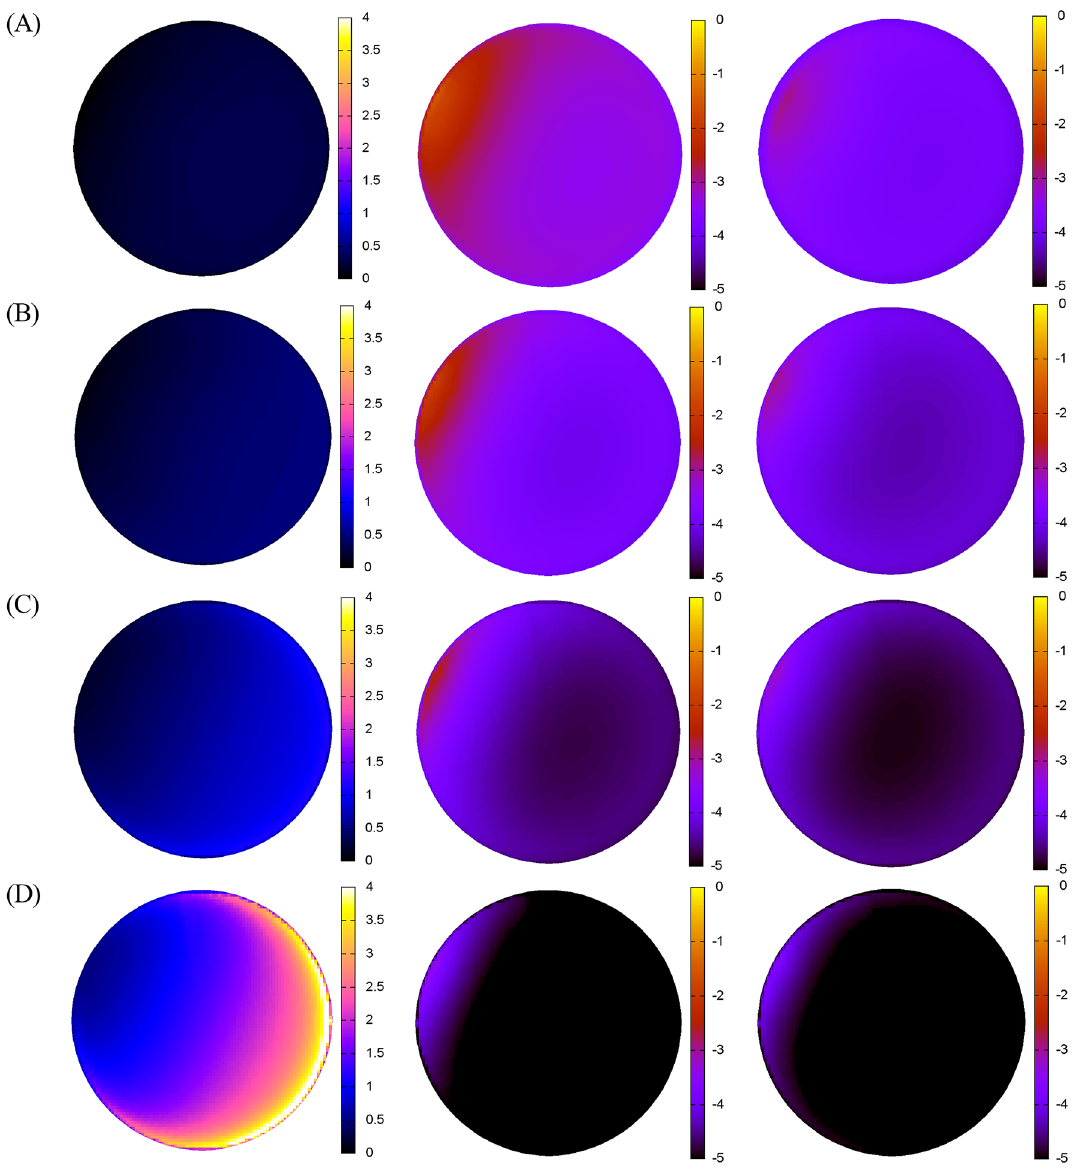
Figure 2. Aerosol-induced changes to NSB at a set of discrete distances, d , from a light source for λ = 530 nm. From ( A ) to ( D ): d = 1.3 km, 2.9 km, 6.7 km and 15.4 km. The leftmost column is the ratio NSB AOD = 0 / NSB AOD = 0.3 , shown on the same linear scale to make valid comparisons possible. The middle and rightmost columns are false-color representations of the all-sky NSB distributions (in arbitrary units on the logarithmic scale) for ‘polluted’ (AOD = 0.3) and ‘clean’ atmospheres (AOD = 0.0), respectively. The zenith and horizon are in the center and at the edge of each plot, respectively. A source of light is at an azimuth angle of 294°. The results in the leftmost column indicate that eliminating air pollution completely reduces NSB most at small distances from light sources, but at a distant place the NSB under clear-air conditions is relatively higher than that in turbid air. Far from the light source ( D ) we observe a decrease of total NSB by one to two orders of magnitude compared to what is obtained for ( A ) in the middle and rightmost columns, so the relative impact of AOD on NSB is probably not critical for either a measuring device or a human